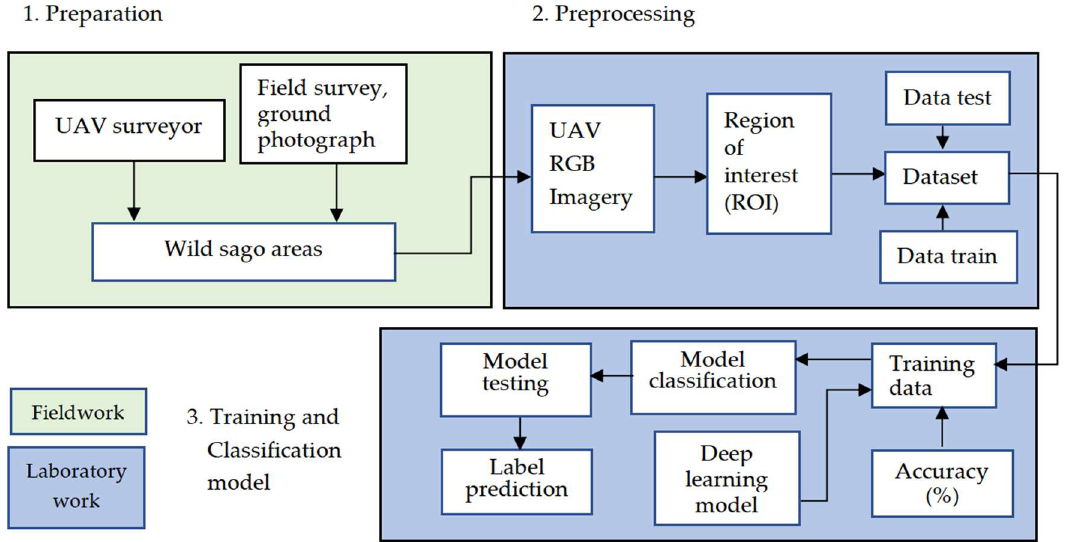
Figure 4. Study workflow. Three stages are practiced with classification and prediction based on three major features of each plant.